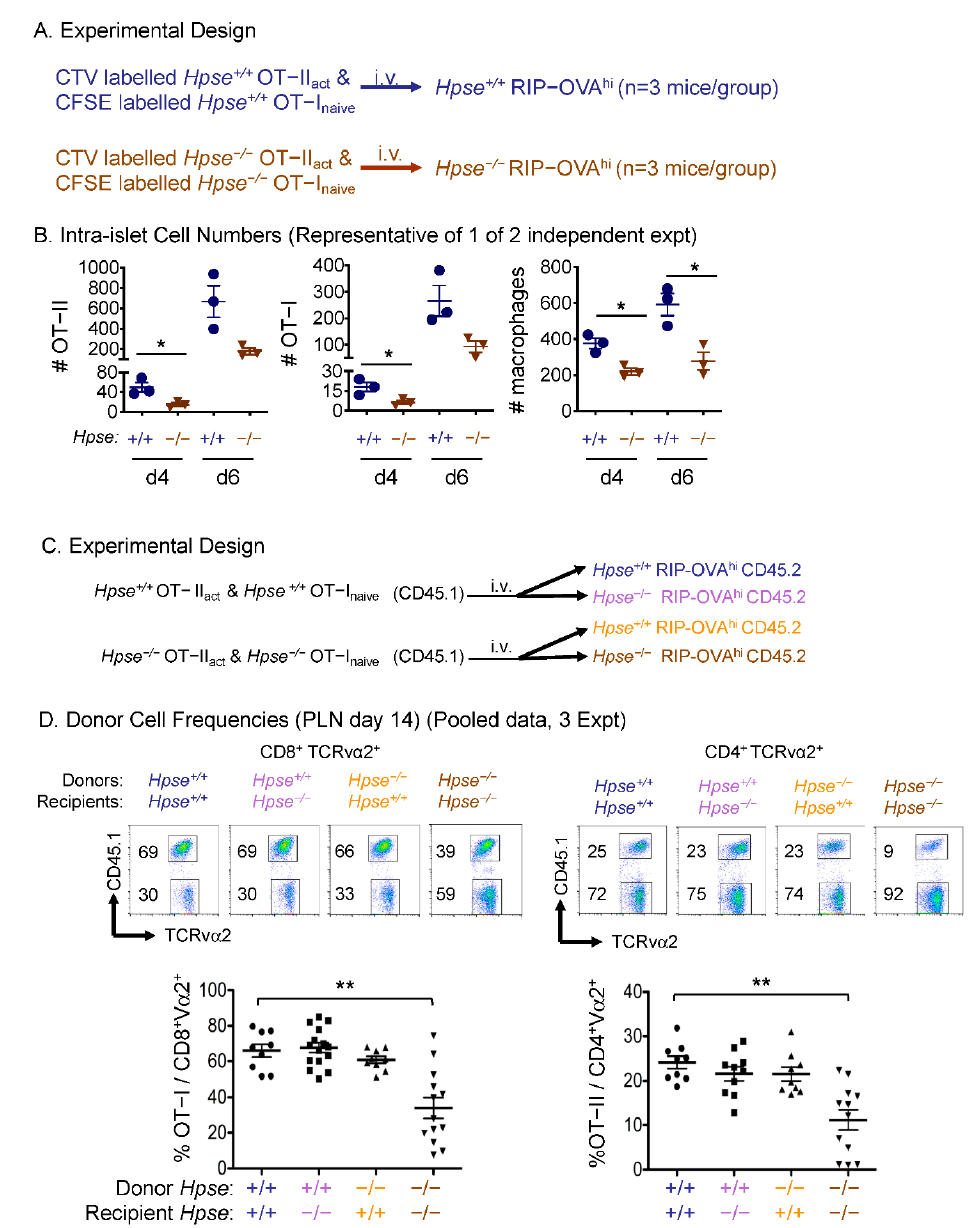
Figure 4. Cellular tracking of transferred OT-I and OT-II T cells in the presence or absence of HPSE-1. ( A ). Experimental design. WT or HPSE-1 deficient activated OT-II and naïve OT-I cells were, respectively, fluorescently labelled with CTV or CFSE and transferred into HPSE-1 genotype matched RIP-OVAhi hosts. ( B ) Intra-islet donor OT-I, OT-II and host CD11b+ F4/80+ (macrophage) numbers per pancreas on day 4 and 6 after transfer. Each point represents cell counts from one individual mouse, WT (blue), deficient (purple). Data are representative of 1 of 2 independent experiments. Significance was assessed by Student’s t- tests, * p < 0.05. ( C ) Experimental design. HPSE-1 WT or deficient CD45.1 naïve OT-I and activated OT-II cells were each injected into two groups of CD45.2 HPSE-1 WT and deficient RIP-OVAhi mice. ( D ) Upper graphs: Representative flow cytometry plots of different treatment groups, with appropriately gated populations. Lower graphs: Frequency of donor OT-I and OT-II cells in the PLNs of individual recipients at day 14. Data are pooled from three independent experiments. Significance was assessed by the non-parametric Kruskal–Wallis test with Dunn’s multiple comparisons test, ** p <